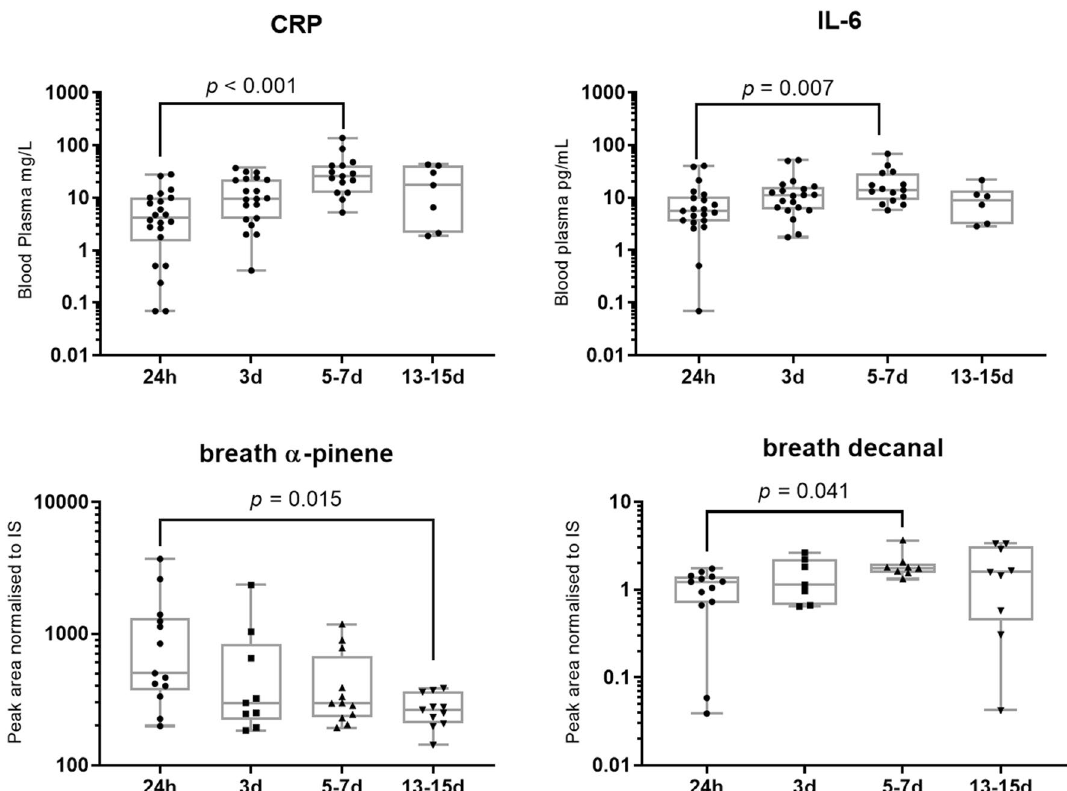
Figure 2. Boxplots (with median line, and whiskers of mininum and maximum value) annotated with Dunn’s test p values showing timepoint group differences for CRP concentration (top left, 24 h = 19; 3 days = 18; 5–7 days = 13; 13-15 days = 6), IL-6 concentration (top right, 24 h = 19; 3 days = 18; 5–7 days = 13; 13–15 days = 6), breath α-pinene peak area (bottom left, 24 h = 13; 3 days = 9; 5–7 days = 12; 13–15 days = 11), and breath decanal peak area (bottom right, 24 h = 13; 3 days = 7; 5–7 days = 8; 13–15 days = 9). IS: internal